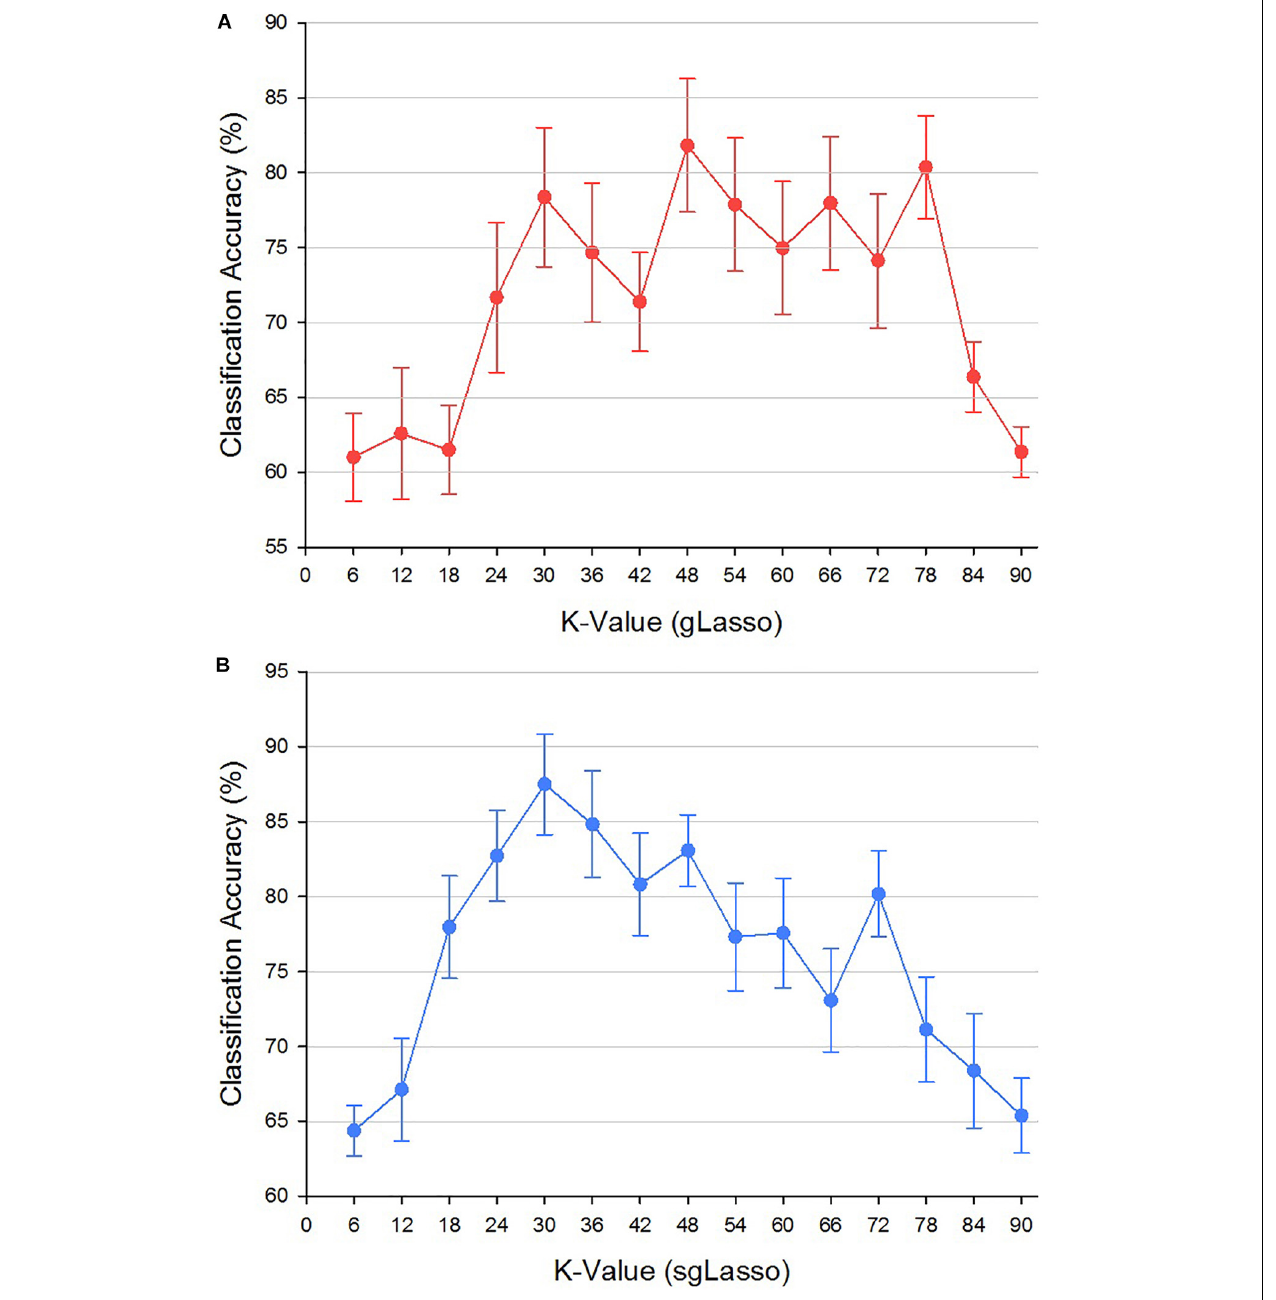
FIGURE 10 | Classification accuracy of different k values based on gLasso and sgLasso methods. (A) Classification accuracy of different k values in gLasso method. (B) Classification accuracy of different k values in sgLasso